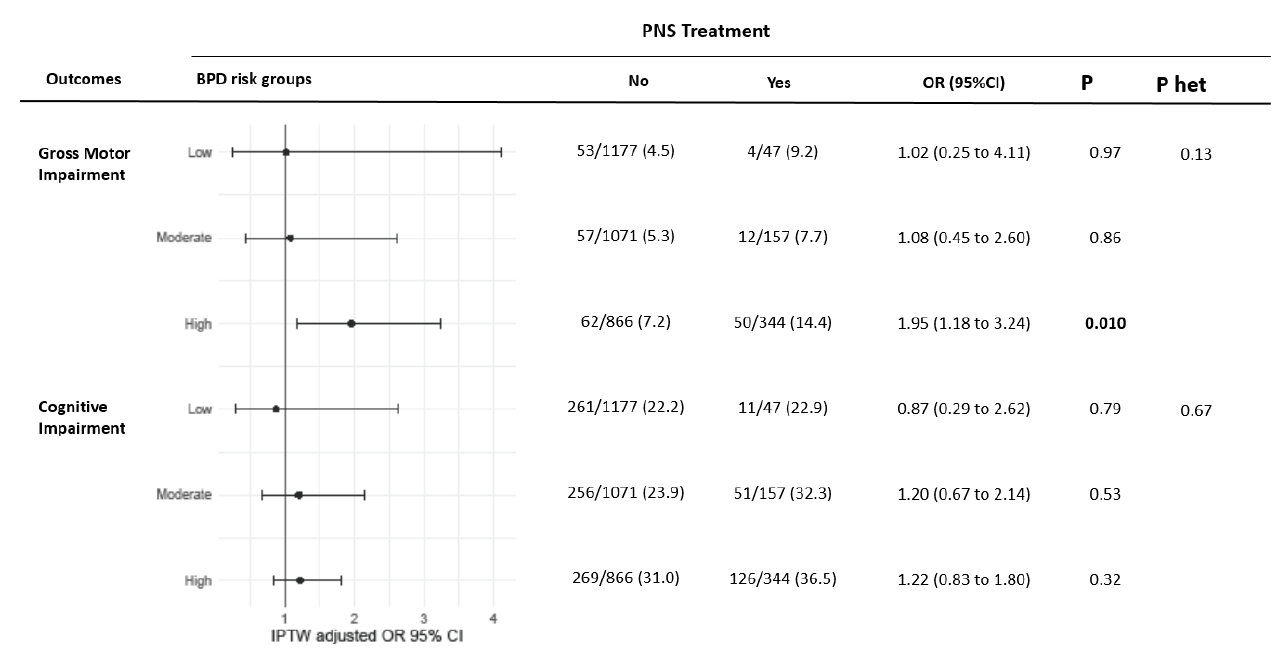
Figure 2. Association of PNS treatment with two-year neurodevelopmental outcomes according to BPD risk groups after IPTW adjustment. Values are reported as no./No. (%). P het indicates p for heterogeneity across BDP risk groups. Descriptive values, OR and p -value were calculated after handling missing values by multiple imputation. Abbreviations: IPTW, inverse probability of treatment weighting; OR, odds-ratio; CI, confidence interval.